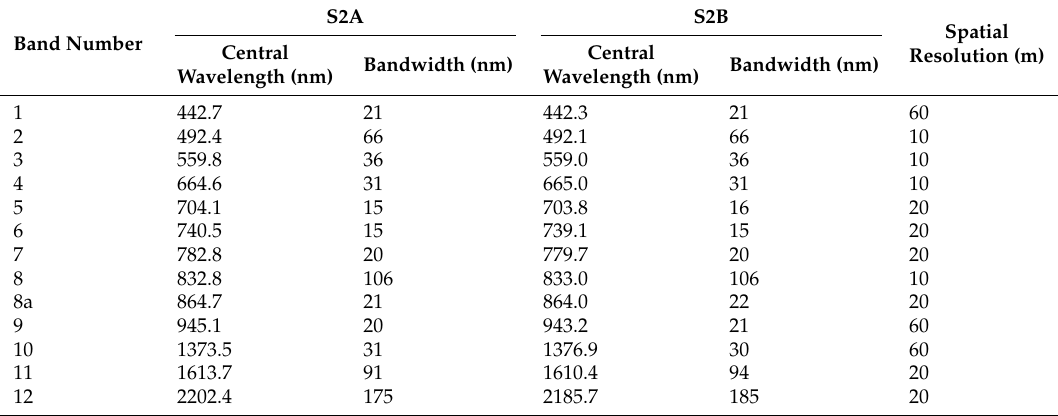
Table 1. Bands of the two Sentinel 2 multispectral instruments used in this study